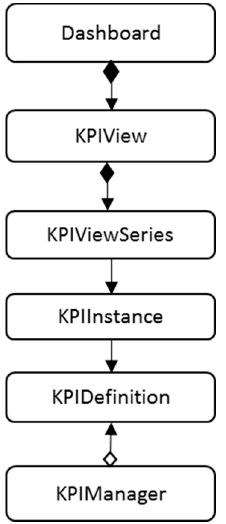
Figure 8. UML of the Informational Model.